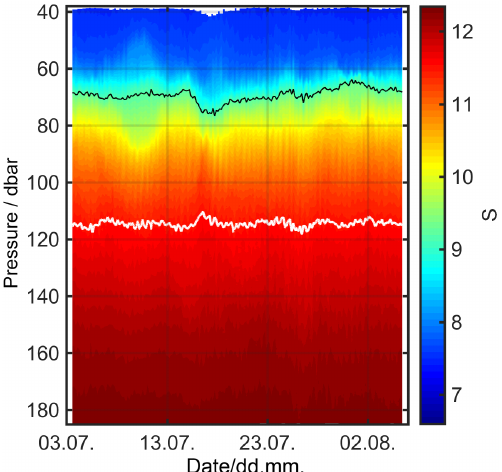
Figure 9. Plot of dissolved oxygen concentration (colour-coded) over deployment date and pressure. All concentrations above 90µmolm − 3 (the threshold between hypoxic and oxic waters) plot- ted in the same colour to emphasise dynamics in the hypoxic waters. The lines at around 70dbar (black) and around 115dbar (white) denote the isopycnals of 1007.6 and 1009.5kgm − 3 respectively, indicating the division between oxic and hypoxic (upper line) and between hypoxic and anoxic waters (lower